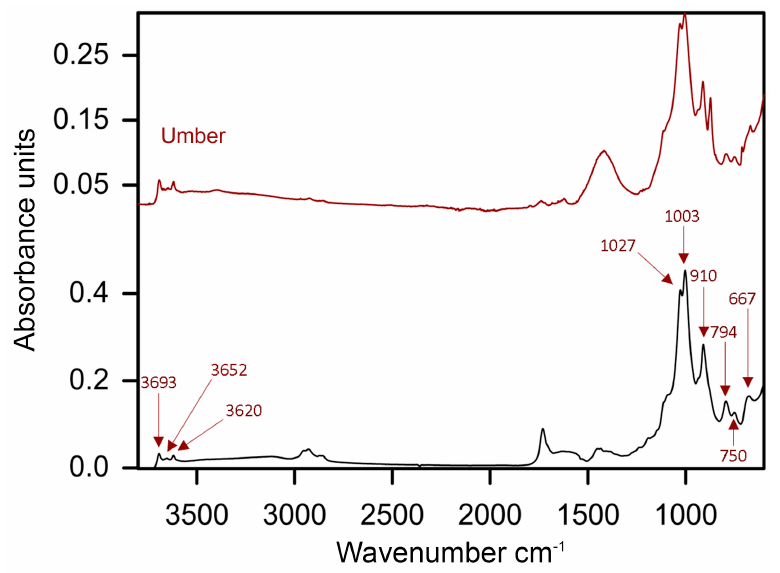
Figure 13. ATR–FTIR spectra of the brown paint of sample 11, extracted from Working at the fields , 1933, with labelled marker peaks of umber and reference spectra of the same pigment.